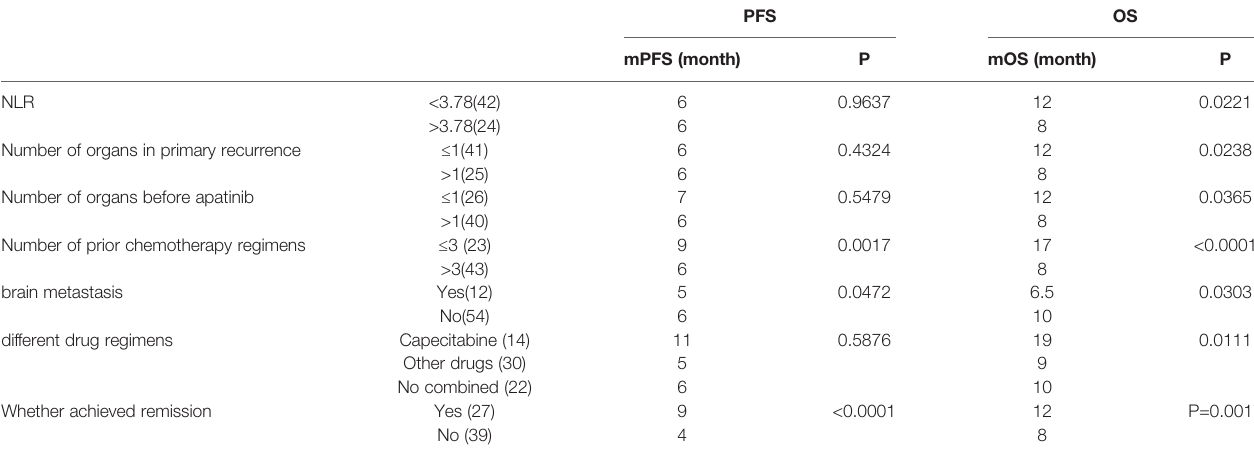
TABLE 4 | Information about possible factors related to PFS and